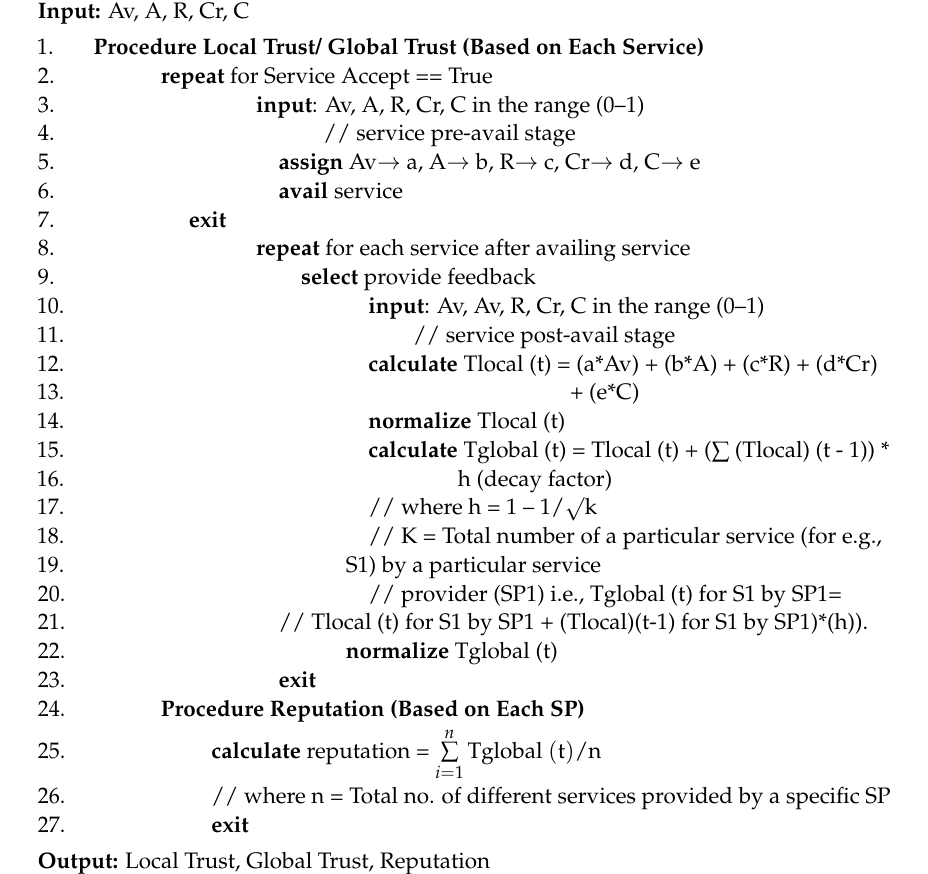
Algorithm A4 Algorithm for Calculating Local Trust, Global Trust, and Reputation